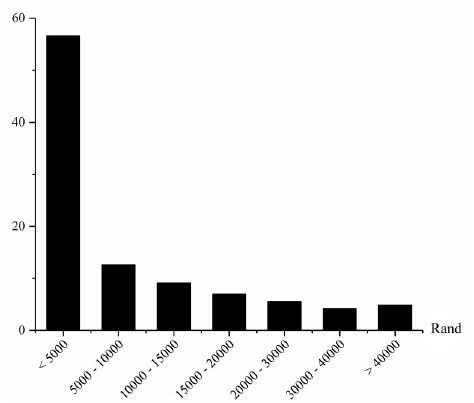
Figure 2. Income levels in the Nzhelele and Levuvhu river catchments.